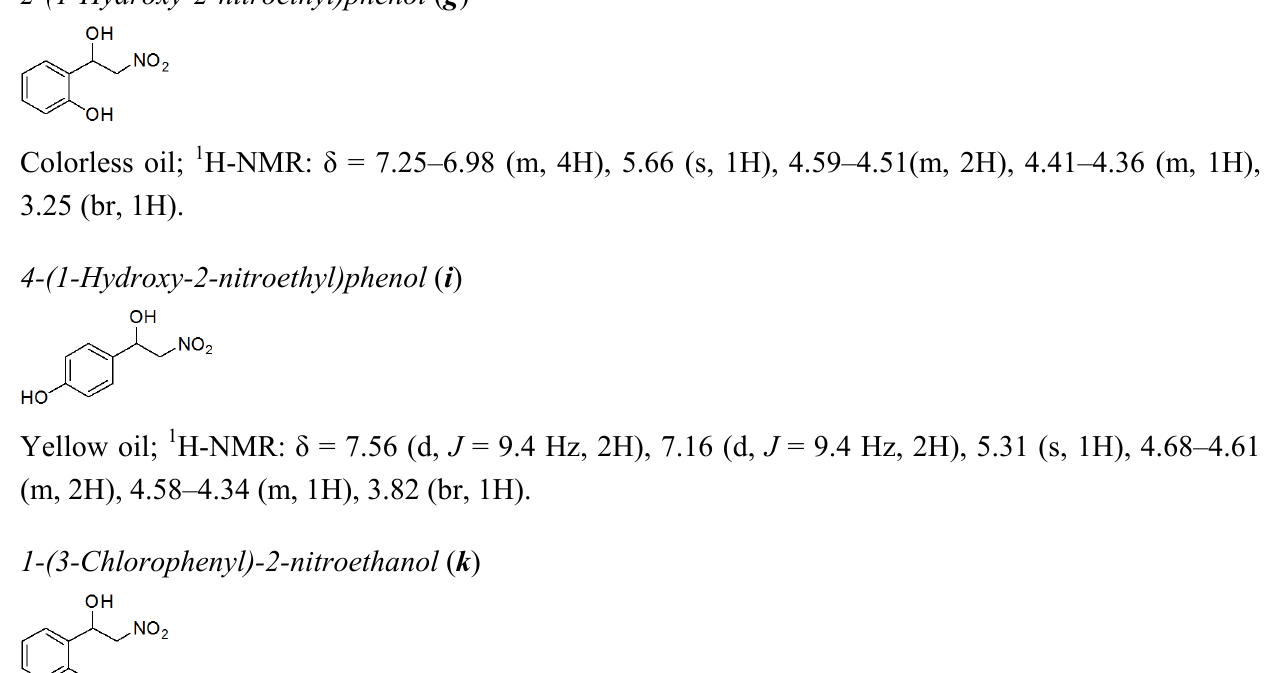
Yellow solid; 1 H-NMR: δ = 8.26 (d, J = 8.8 Hz, 2H), 7.63 (d, J = 8.5 Hz, 2H), 5.24–4.76 (m, 1H), 4.52–4.22 (m, 2H), 3.65 (br, 1H). 2-(1-Hydroxy-2-nitroethyl)phenol ( g )